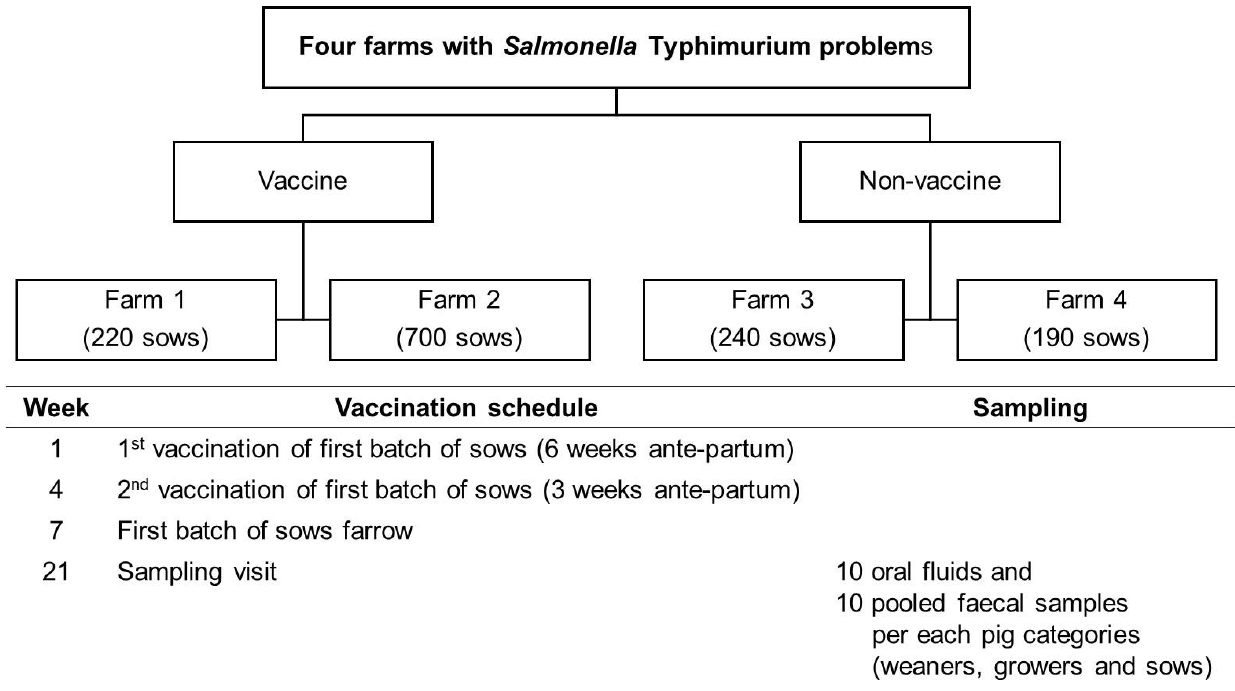
Figure 1. Experimental design: schedule of the vaccination programme and sampling scheme.